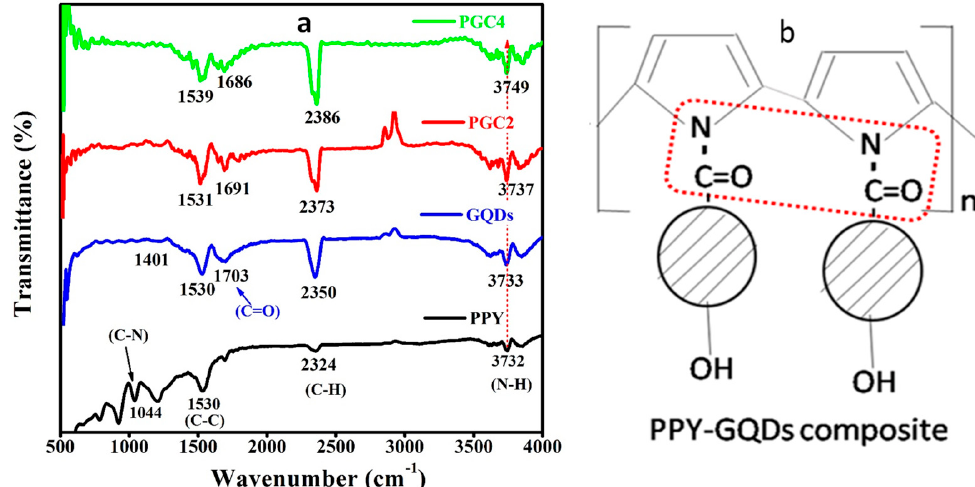
Figure 1. FT ‐ IR spectra of Polypyrrole, Graphene quantum dots, PGC2, PGC4 composites ( a ), and proposed chemical interaction in PPy ‐ GQDs composite ( b ).